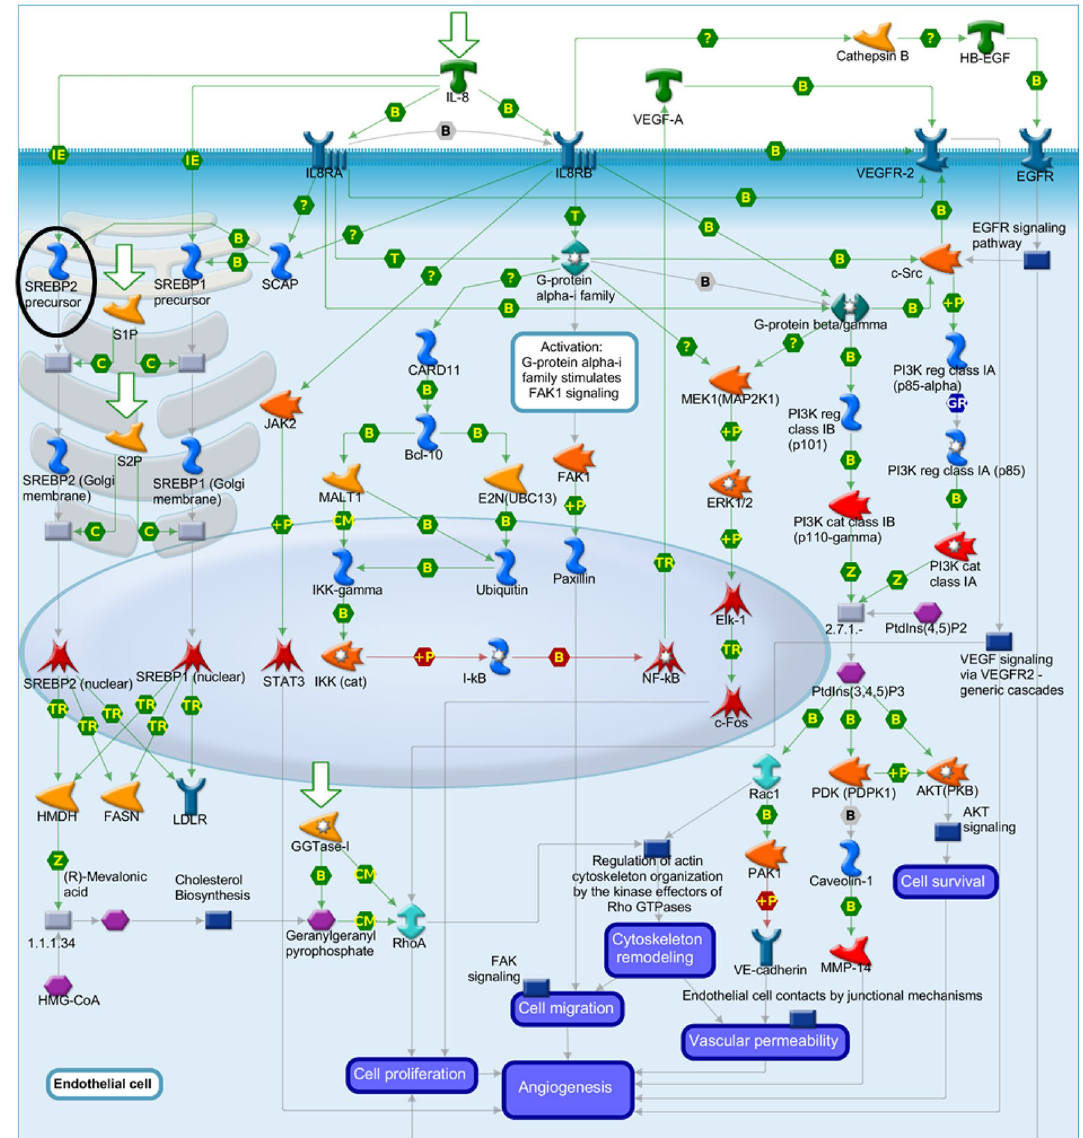
Figure 3. Development role of interleukin-8 (IL-8) in angiogenesis pathway map. Image created by MetaCore (Clarivate Analytics) [https:// portal. genego. com/]. Activation is indicated by green arrows, inhibition is indicated by red arrows, and unspecific relationship is indicated by gray arrows. The SREBP2 precursor is highlighted with a black circle. Nodes represent GeneGo Network objects (genes or gene complexes). For more information, see https:// portal. genego. com/ legen ds/ MetaC oreQu ickRe feren ceGui de.